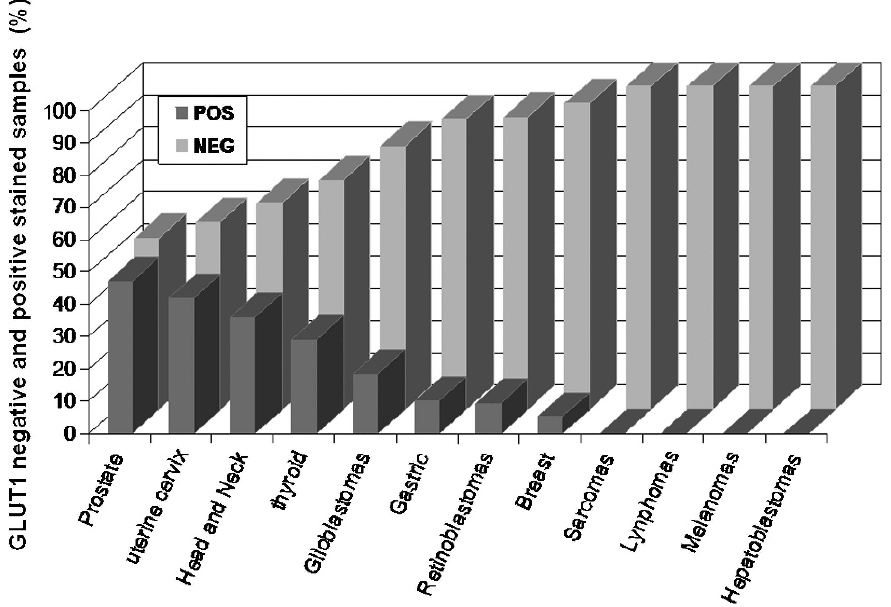
Figure 1 - Profile of GLUT1 expression by histological tumor type. The graph shows the percentage of GLUT1-positive (POS) and -negative (NEG) samples determined